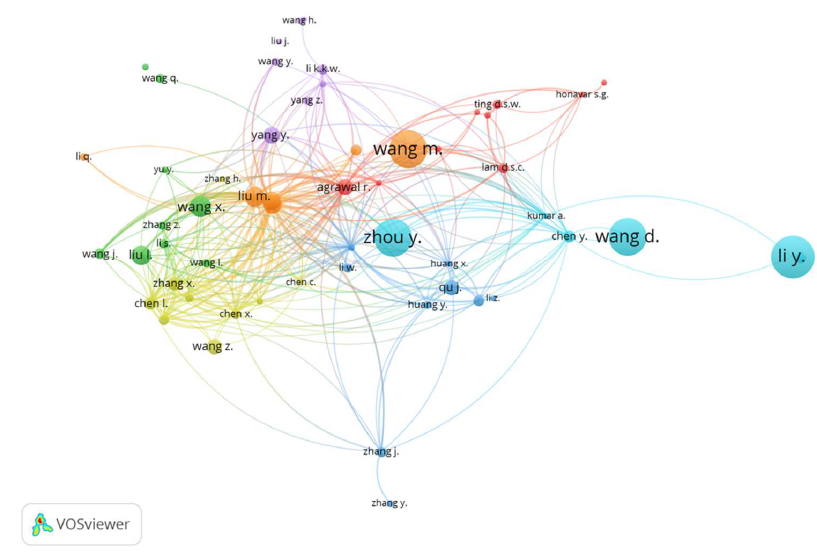
Figure 5. Network visualization map of the author citation analysis. Highly cited authors are indicated by the larger size of the node. Y. Li is the author with the highest number of citations (2351). Blue and orange are neurology clusters, while in the red cluster ophthalmology predominates and in purple we represent authors from fields such as computer, biostatistics, and public health. Further information that can be analyzed from our results is who has been cited in the works retrieved in our search from a list of references of each document. Figure 6 is the map of authors’ co-citations for which the authors with a minimum of 55 citations